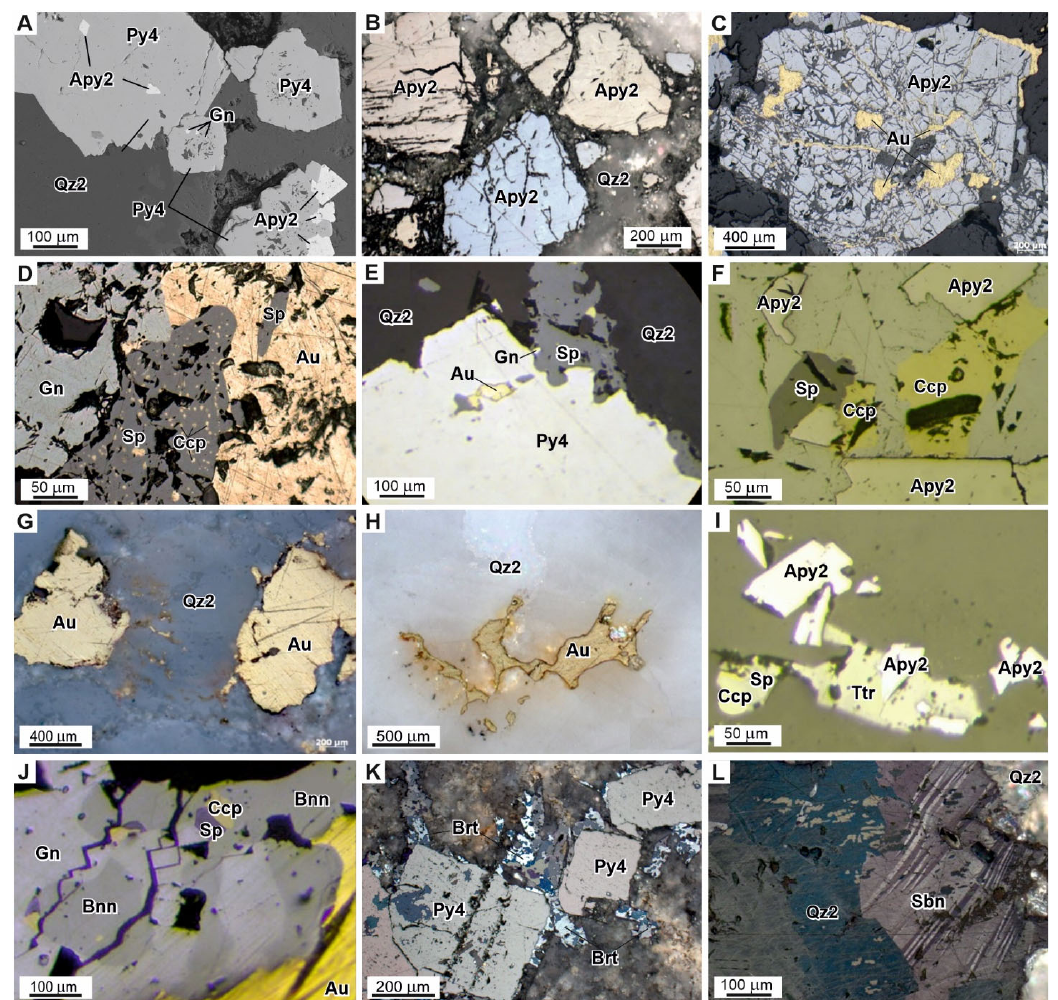
Figure 7. Photomicrographs showing the representative mineral assemblages and microtextures of the ore minerals of each vein ‐ type (( A )—backscattered electron images, ( B – L )—reflected light) of the studied OGDs, central YKMB: ( A ) pyrite and arsenopyrite intergrowths in a quartz vein; ( B ) cataclase structures in arsenopyrite grains; cracks are healed with quartz in the Au ‐ polysulfide ‐ quartz paragenesis; ( C ) in cataclazed arsenopyrite aggregate, native gold developed along cracks; ( D ) sphalerite–galena–chalcopyrite aggregate with an allotriomorphic blastic structure. Chalcopyrite emulsions in sphalerite aggregates with a solid solution decomposition structure; ( E ) microtexture from corrosion and substitution of pyrite (Py) crystal caused by minerals of the Au ‐ polysulfide ‐ quartz paragenesis; ( G ) native elongated lumpy gold in interstitial quartz grains; ( H ) lumpy ‐ branched native gold in microcracks; ( I ) tetrahedrite aggregates intergrown with arsenopyrite; ( J ) intergrowths of burnonite with minerals from the Au ‐ polysulfide ‐ quartz paragenesis; ( K ) microtextures from berthierite corrosion due to pyrite crystals; ( L ) euhedral crystals made of regenerative quartz in stibnite aggregates. Abbreviations: Gn—galena, Sp—sphalerite, Ccp—chalcopyrite, Apy—arsenopyrite, Ttr—tetrahedrite, Bnn—burnonite, Brt—berthierite, Sbn—stibnite.